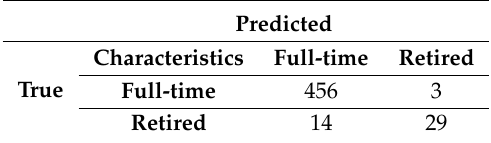
Figure 6. The model prediction of employment status. Table 6. The confusion matrix of employment status of